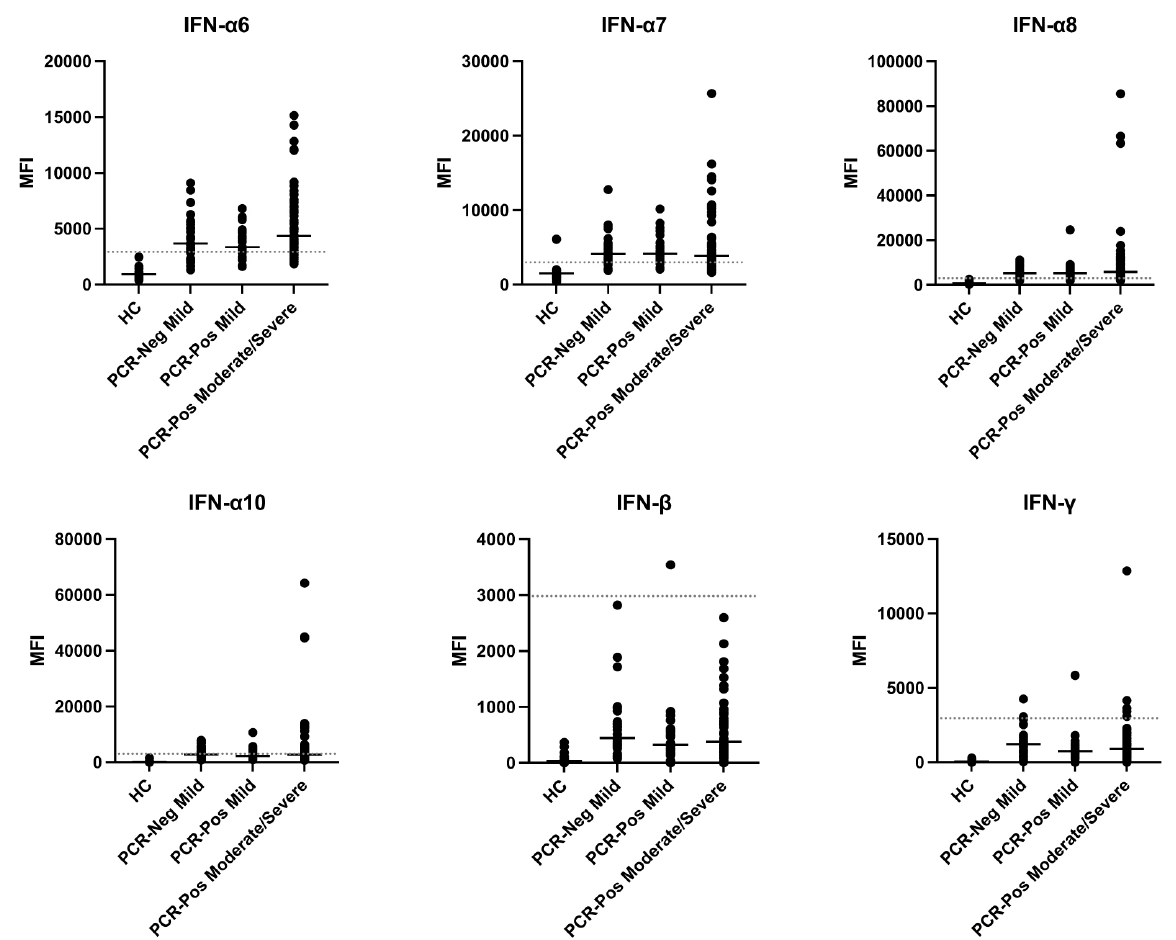
Figure 6. Prevalence of anti-interferon antibodies in a subset of patients. Plasma IgG antibodies were profiled with a 58-plex bead-based protein array containing cytokines and chemokines. Example distributions of autoantibodies against interferons in healthy controls (HC, n = 17), PCR-negative mild patients (n = 31), PCR-positive mild patients (n = 27), and PCR-positive moderate/severe patients (n = 60) are shown. MFI is shown on the y-axis. A static cutoff of 3000 MFI, depicted by the gray dashed line, was used to determine positive anti-interferon